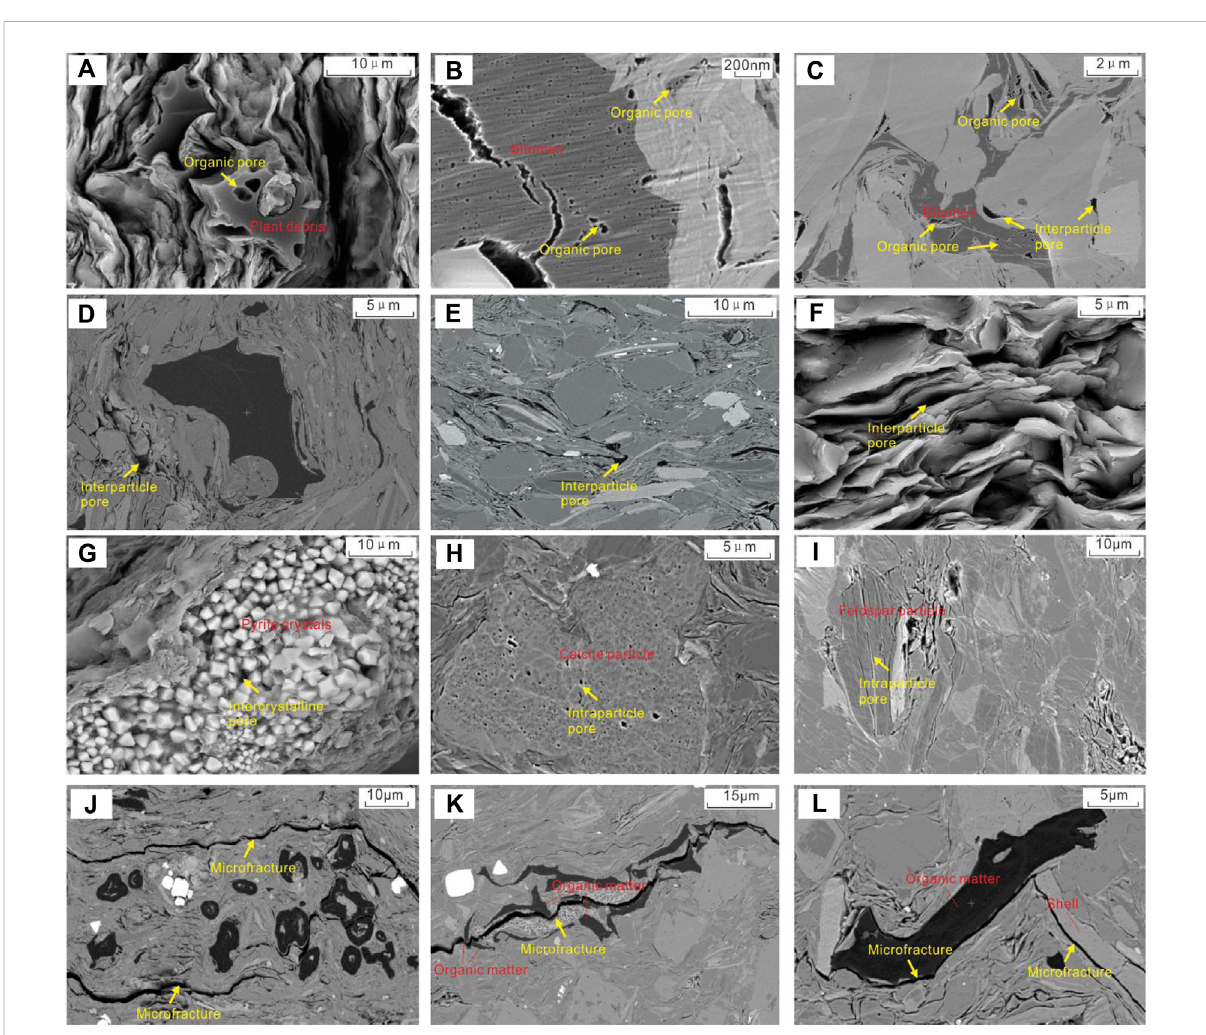
FIGURE 3 FE-SEM images of reservoir spaces in the Jurassic Dongyuemiao lacustrine shale in Eastern Sichuan Basin. (A) Primary organic pore in plant debris, Well XY3, 2959 m; (B) Abundant organic pore in bitumen, Well FY10, 2,766.46 m; (C) Organic pore between bitumen and mineral particles, Well FY10, 2,800.97 m; (D) Interparticle pores between mineral particles, Well TL601, 2,743.5 m; (E) Interparticle pores between mineral particles, Well TL601, 2,755.13 m; (F) Interparticle pores between clay mineral, Well XY3, 2,953.22 m; (G) Intercrystalline pores between pyrite crystals, WellXY3,2,935.1 m; (H) Abundantintraparticle poresincalcite particle,Well TL601,2,731.58 m; (I) Intraparticleporesinfeldsparparticle,WellTL601, 2,728.05 m; (J) Microfracture, Well TL601, 2,750.21 m; (K) Microfracture dislocating organic matter, Well TL601, 2,731.58m; (L) Microfractures around organic matter and mineral particles, Well TL601, 2,731.58